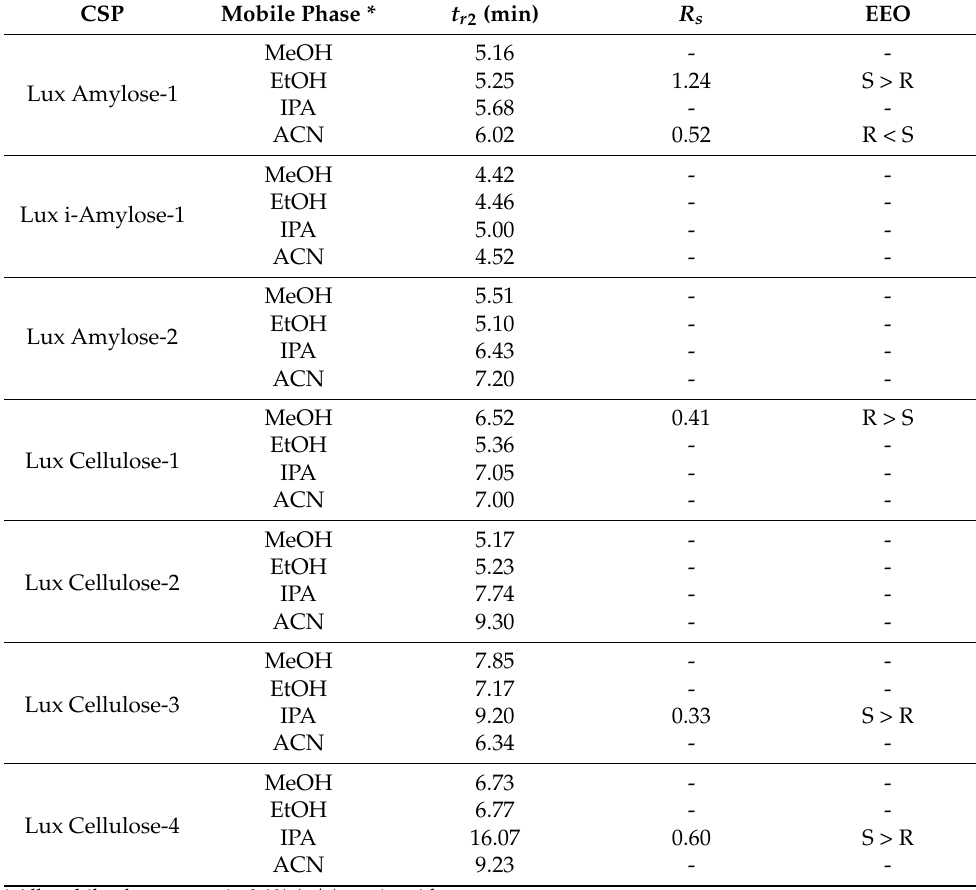
Table 1. Chromatographic data from the screening phase—resolution ( R s ), enantiomer elution order (EEO), and retention time of second-eluting enantiomer (t r2 ).